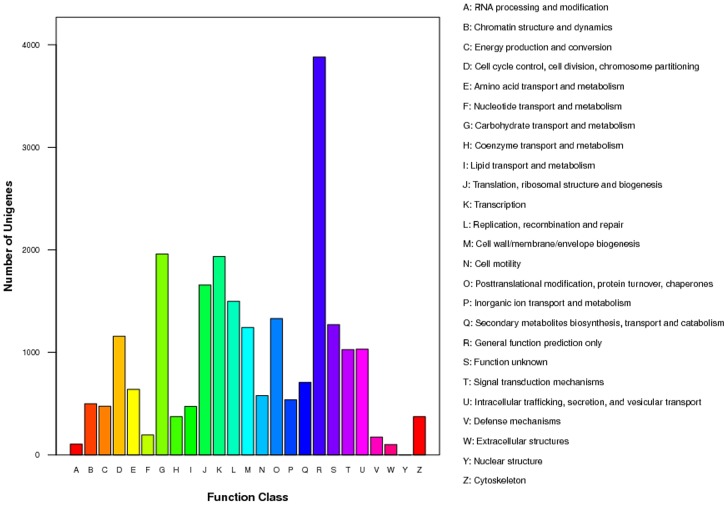
Classification of the clusters of orthologous groups (COG) for the M. domestica transcriptome.8,549 unigenes (31.6% of the total annotated unigenes) were divided into 25 specific categories.